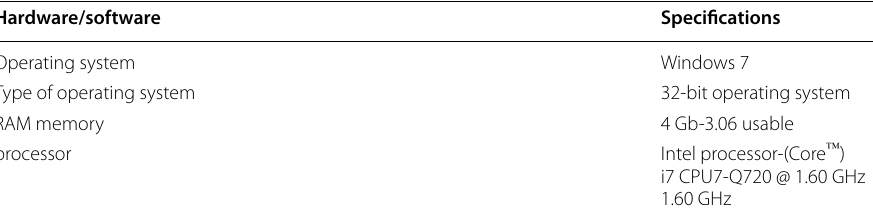
Table 2 System specifications for simulating and evaluating the results Hardware/software